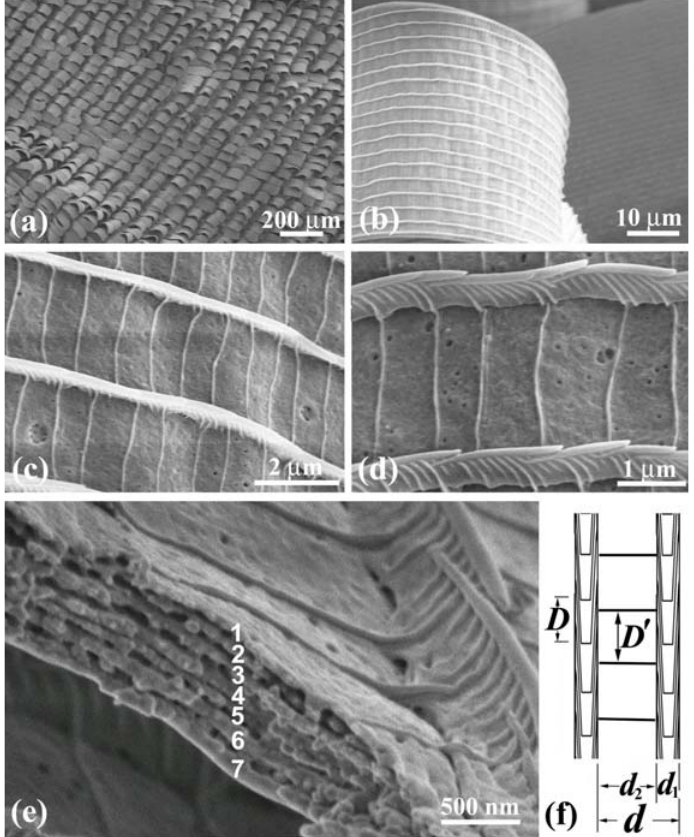
Figure 8. SEM images of the dorsal scales of the male C. ataxus . ( a ) Law-magnified image of curled scales; ( b ) A curled scale; ( c ) Ridges and cross ribs in the scale; ( d ) Enlarged image of the ridges and ribs; ( e ) Cross-section of a groove enclosed by the ridges and ribs, revealing seven piled layers; ( f ) Schematic of the fine structure of the scale (adapted from